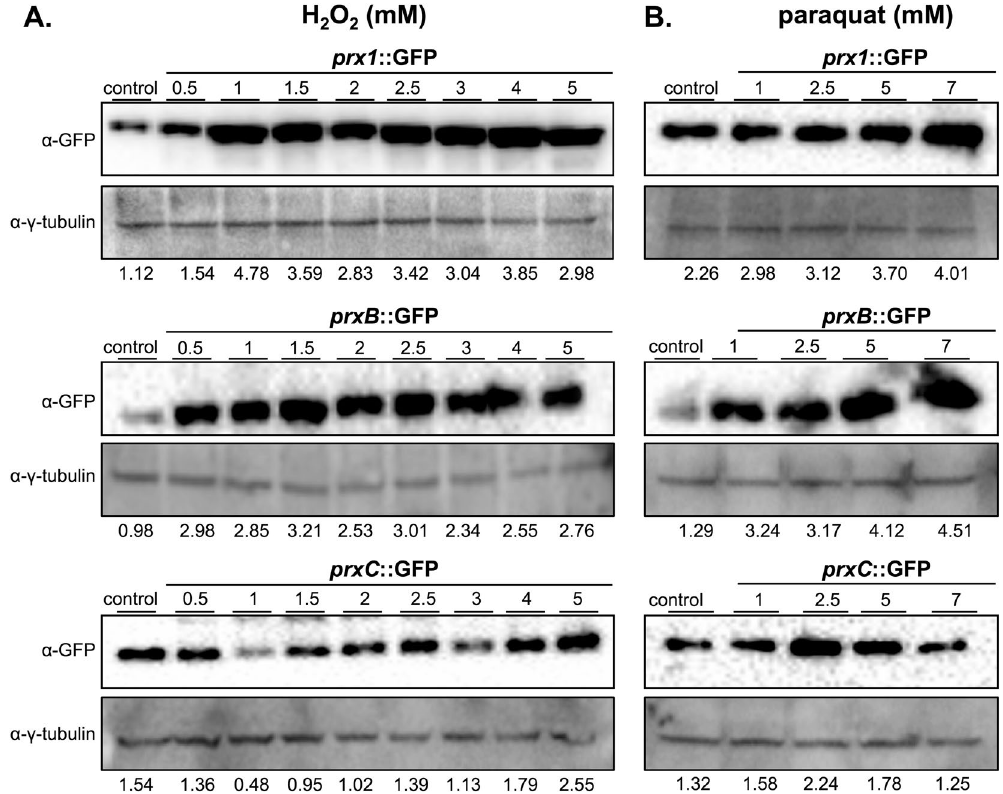
Figure 7. Prx1, PrxB and PrxC expression upon oxidative challenge. Prx1::GFP, PrxB::GFP and PrxC::GFP strains were grown for 24 hours in MM and subsequently exposed to increasing concentrations of H 2 O 2 ( A ) or paraquat ( B ). The total amount of each protein was detected using an anti-GFP antibody. The anti- γ -tubulin antibody was used as a loading control. Densitometry analysis of Western blot signals is shown on the bottom of each image and represents the Prx/ γ -tubulin intensity ratio. The experiments were done in triplicate and a representative experiment is shown. In the figure are reported the cropped gels/blots obtained by each protein evaluation. All gels were run in the same experimental conditions. Full-length blots are presented in Supplementary Figure